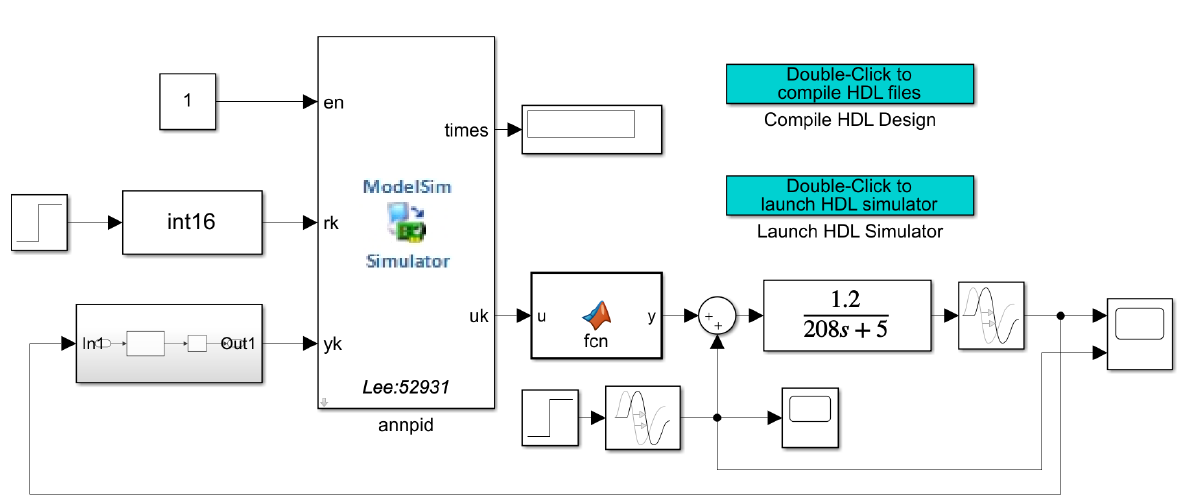
Figure 20. Simulink simulation model of closed loop control